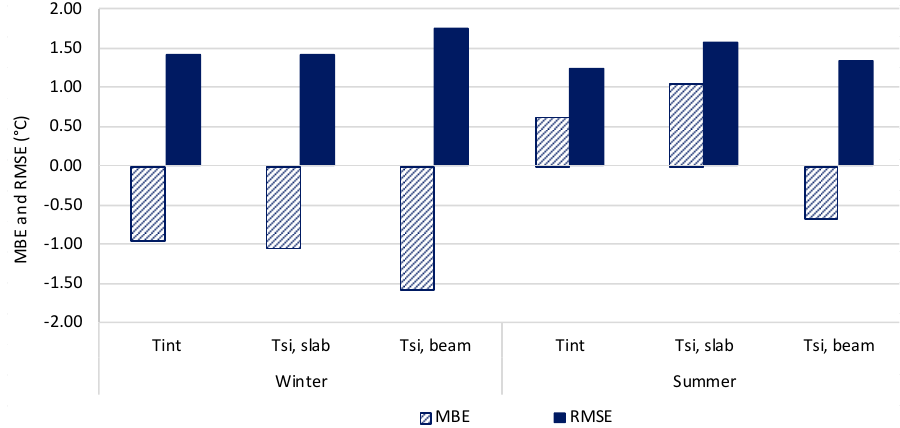
Figure 4. Mean bias error (MBE) and root-mean-square error (RMSE) of the indoor temperature (Tint) and of the internal surface temperatures in the slab (Tsi,slab) and beam (Tsi,beam) for validation of the numerical model.